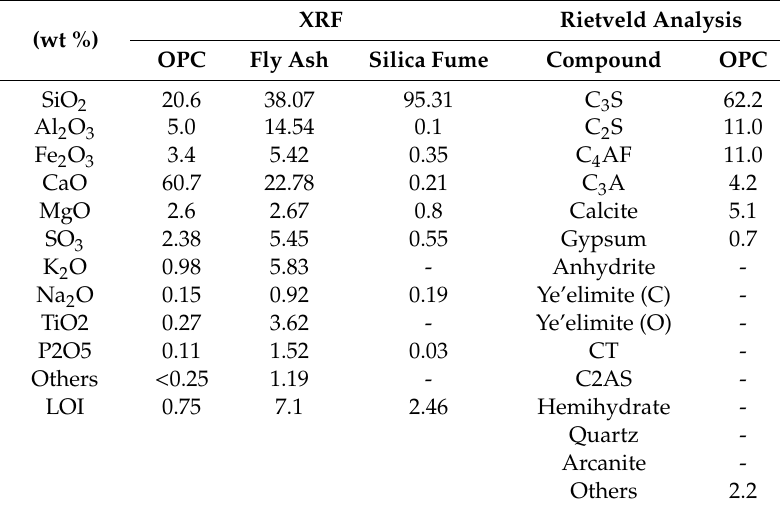
Table 1. Chemical composition of binder materials used in this